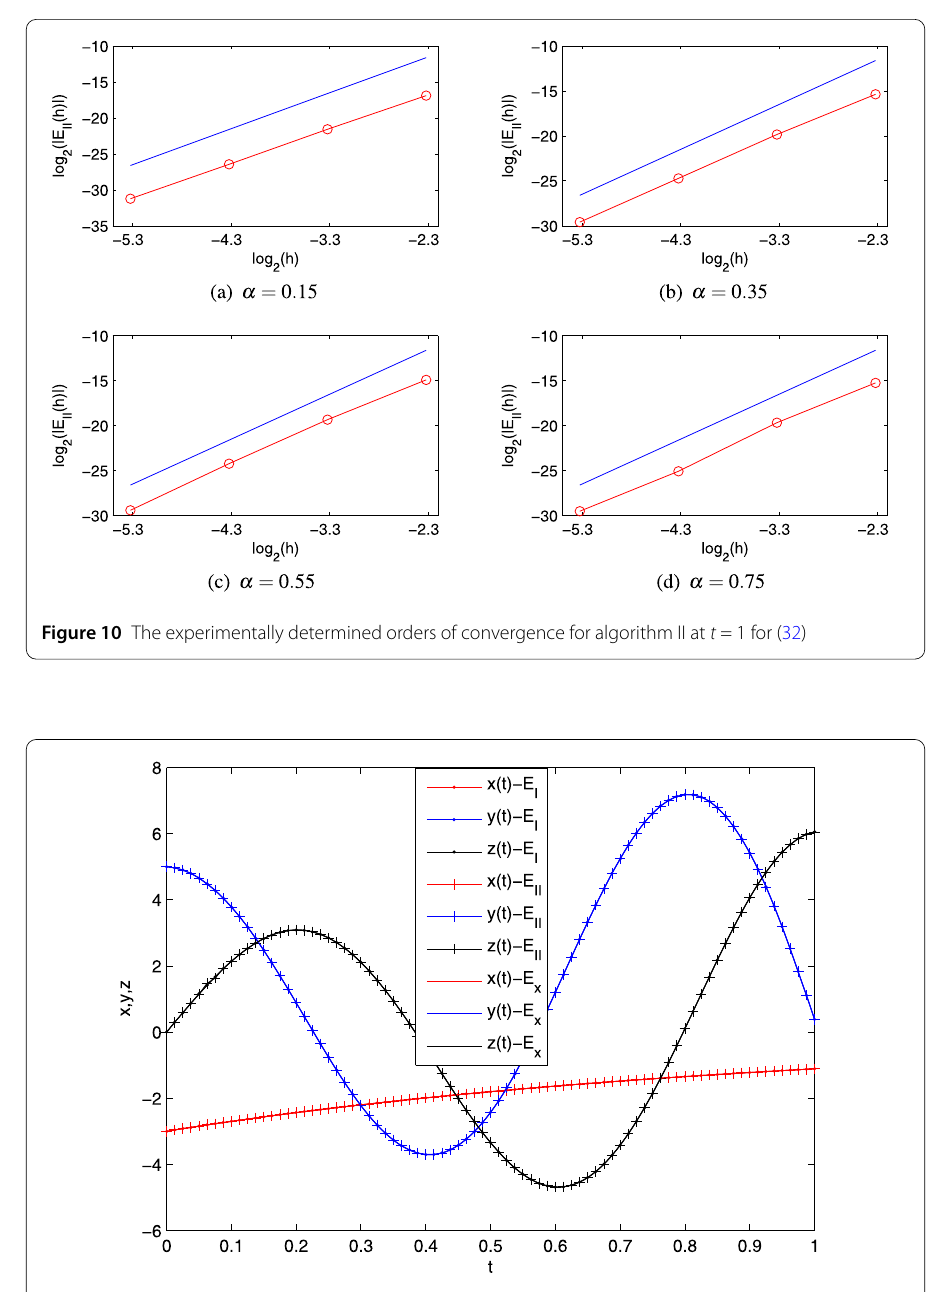
Figure 11 Comparison of solutions for IVP (33) ( α = 0.925, h =